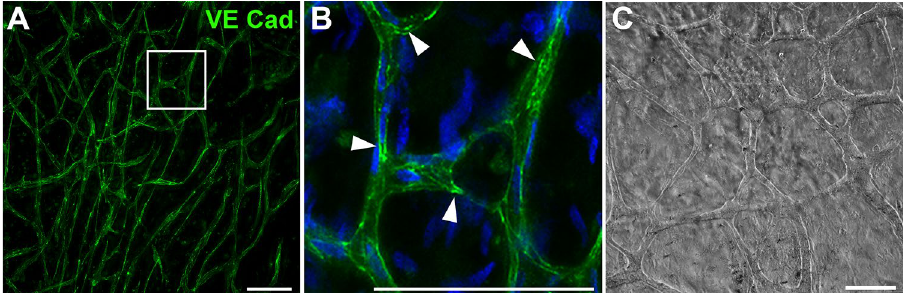
Figure 5. Tube formation of peripheral nerve derived ECs following cultivation on Matrigel under serum deprivation for 12 h. ( A ) Tube-forming endothelial cells, labeled by anti-VE-cadherin, revealed an intense immunoreactivity at endothelial adherens junctions (arrowheads) within the capillary tubes ( B ). Cell nuclei in the inset are labeled with DAPI (blue). ( C ) Brightfield image of EC tubes in regular media. These results were reproduced four times with ECs at passage 1 derived from four independent isolation procedures of individual patients. Scale: 100